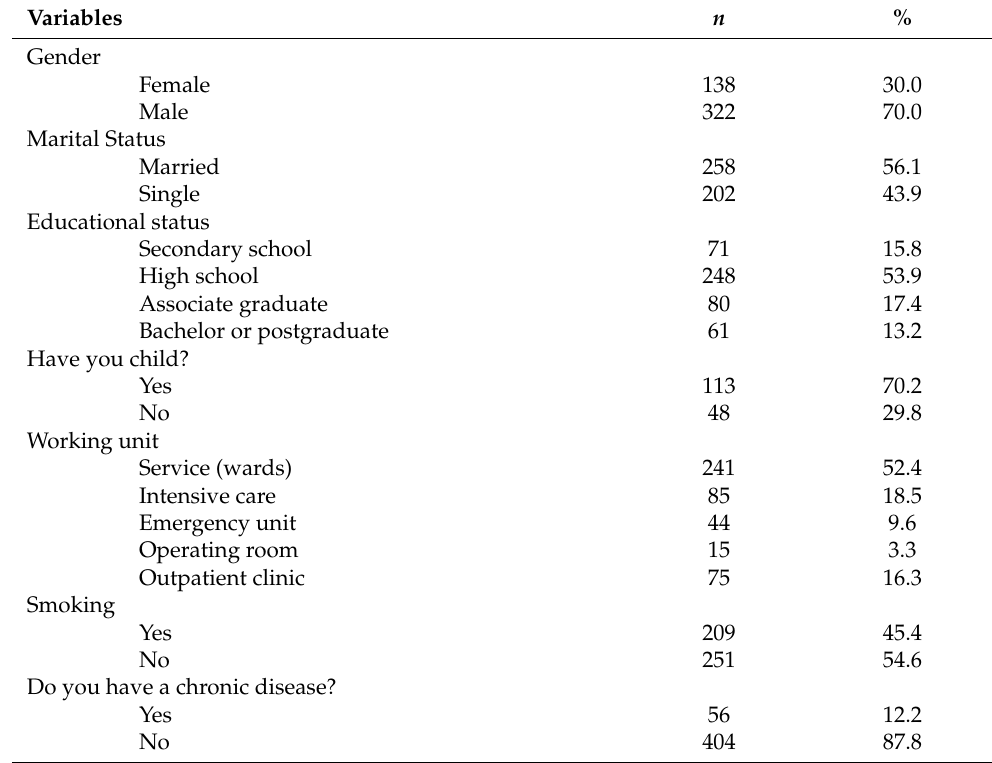
Table 1. Distribution of the participants’ socio-demographic